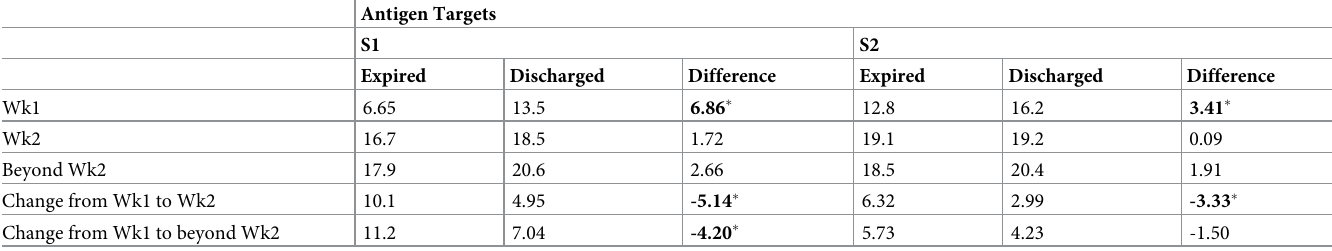
Table 2. Estimates from Linear Mixed Model (Model 1) of Anti-S1 and Anti-S2 IgG Titer Values (log) by Time and Outcome.